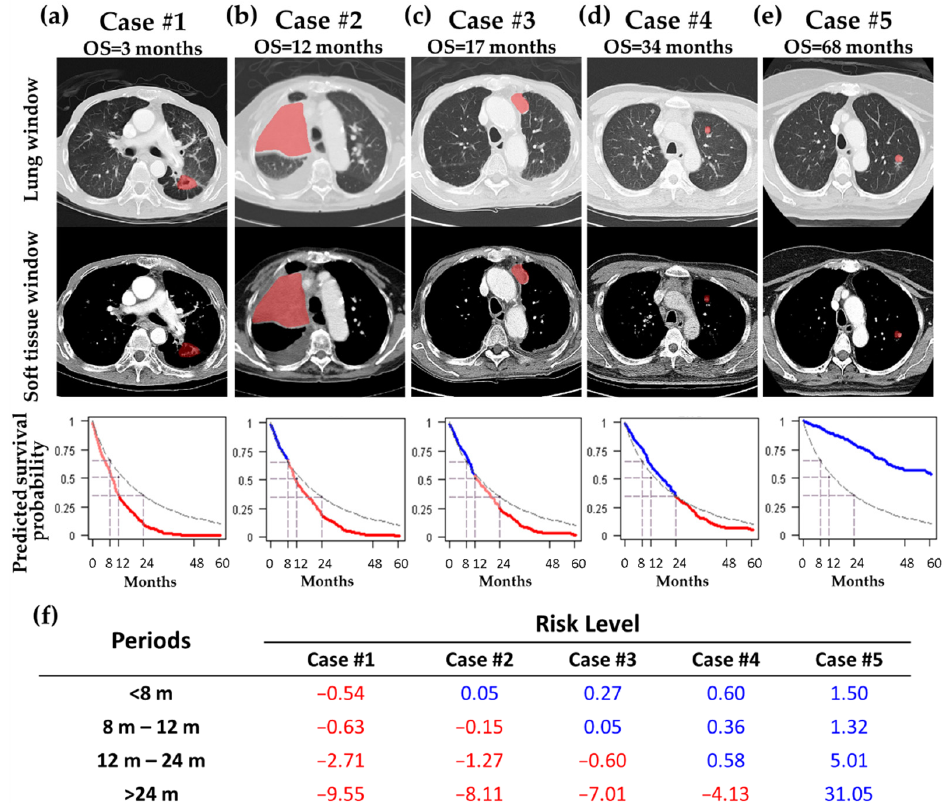
Figure 2. Demonstration of the predictive survival curve, AUC difference, and CT images in five patients. Five predictive survival curves ( a – e ) were displayed with OS of 3, 12, 17, 34, and 68 months. The first and second rows display lung and soft tissue windows of lung CT images (pink ROIs indicate the segmented tumors). The third row shows personalized survival prediction (color line) and referenced risk curves (dash line). For the colored line, blue segments indicate that the patients were at a low risk during the period, and red segments demonstrate that the patients were at a high risk during the period. ( f ) lists the risk levels of the five patients during four periods (<8, 8–12, 12–24, and >24 months).